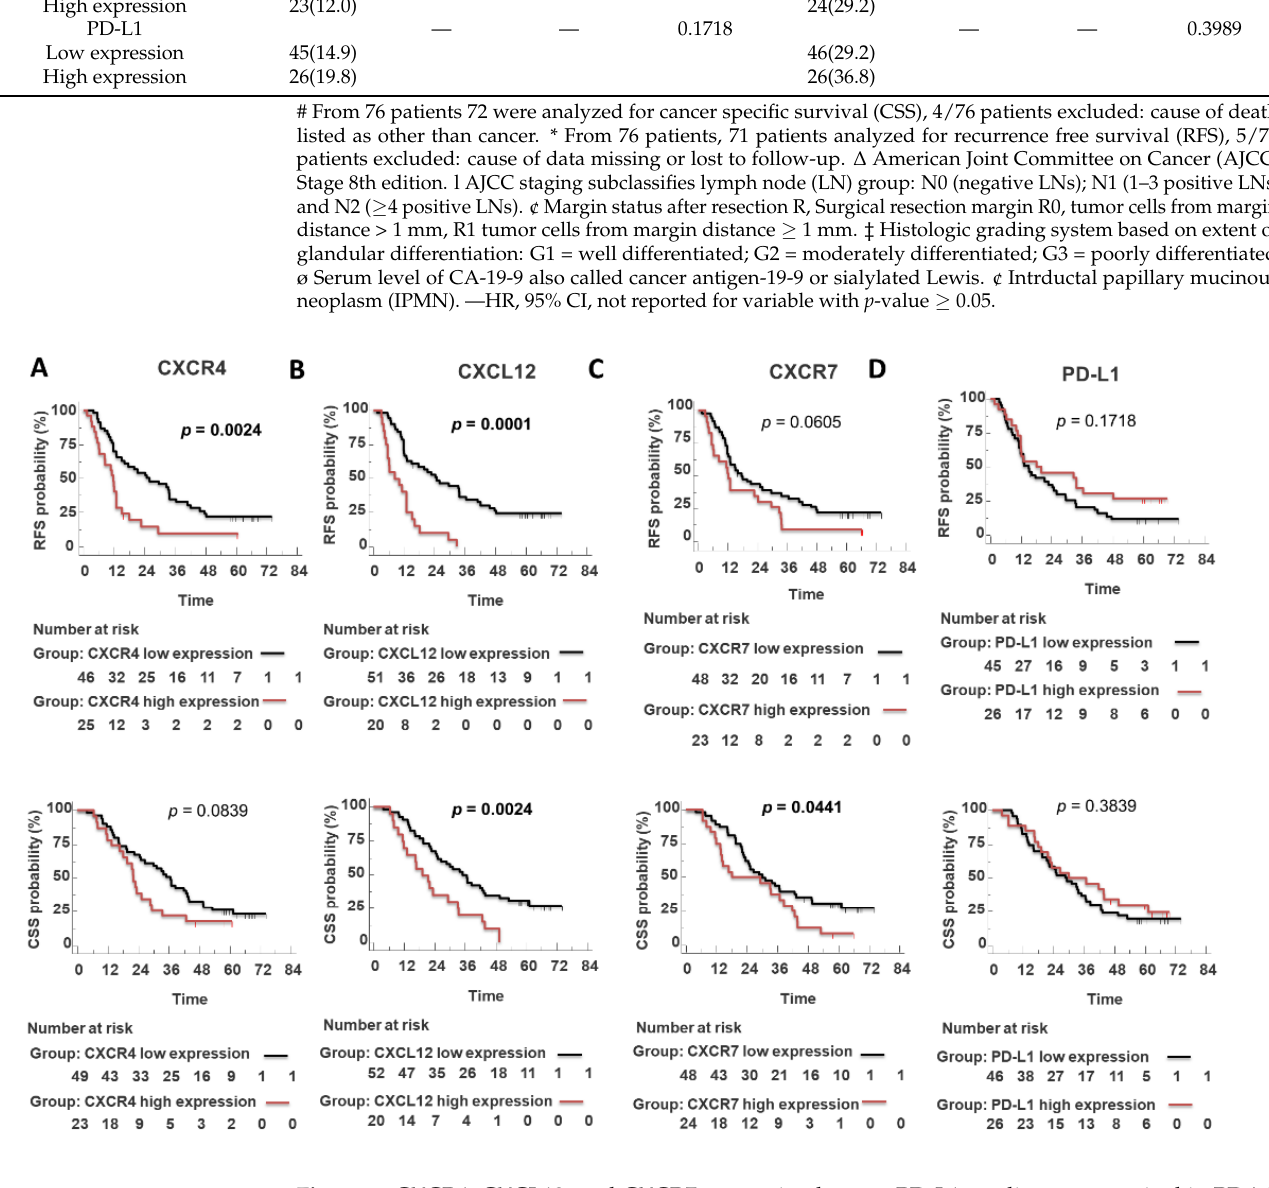
Figure 5. CXCR4, CXCL12, and CXCR7 expression but not PD-L1 predict poor survival in PDAC patients ( A – D ). Survival LogRank analysis correlates with recurrence-free survival (RFS) and cancer-specific survival (CSS) (months).